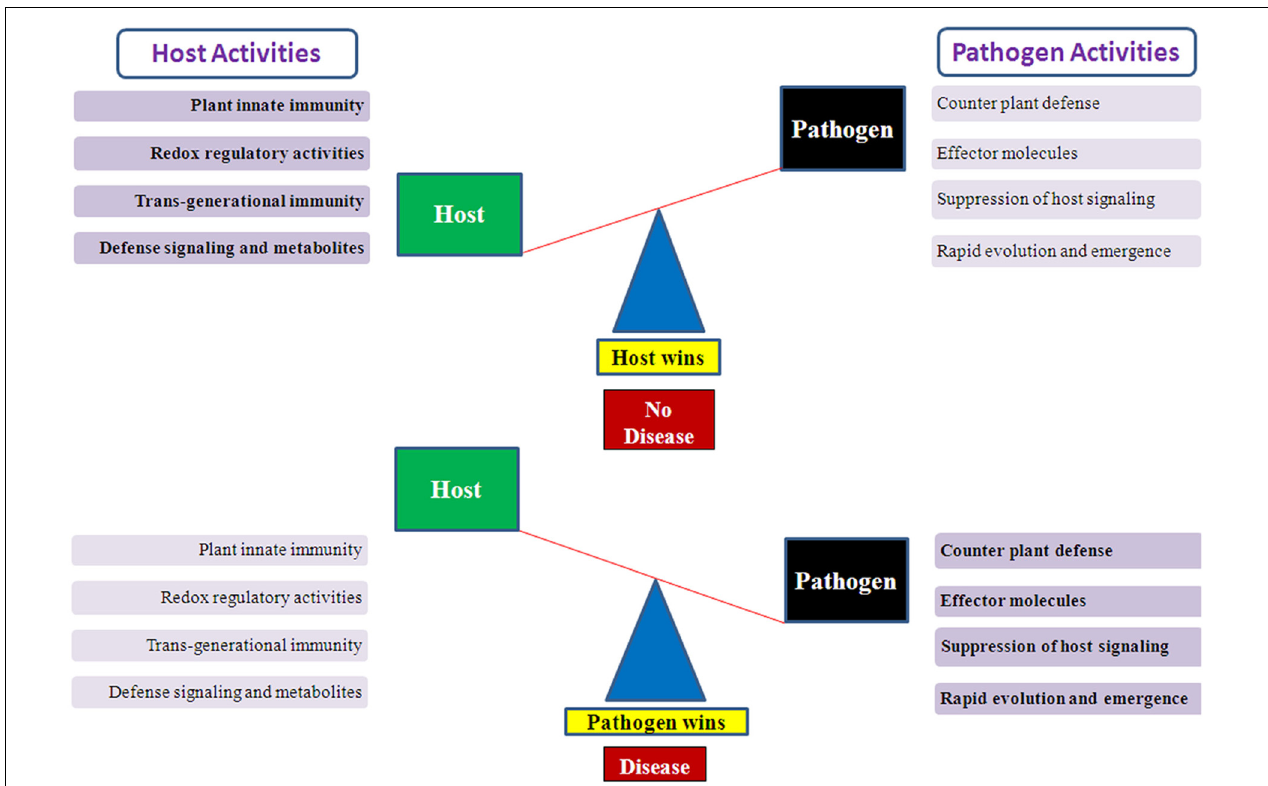
FIGURE 1 | Illustration showing host − pathogen activities which determine the host wins or pathogen wins situation. A conceptual diagram showing the balance mechanism between host − pathogens activities. When host activities suppress the pathogen effect then host wins and plants survive the pathogen attack but when pathogen defeat the host defense system then pathogen wins and disease